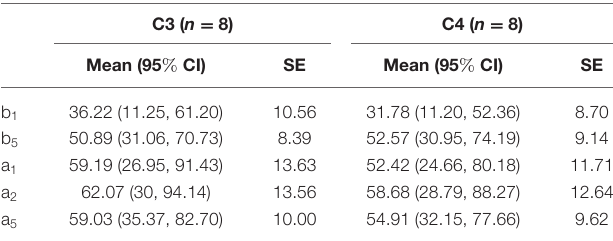
TABLE 2 | Correlation between final performance of expert and EEG response of novice of acute